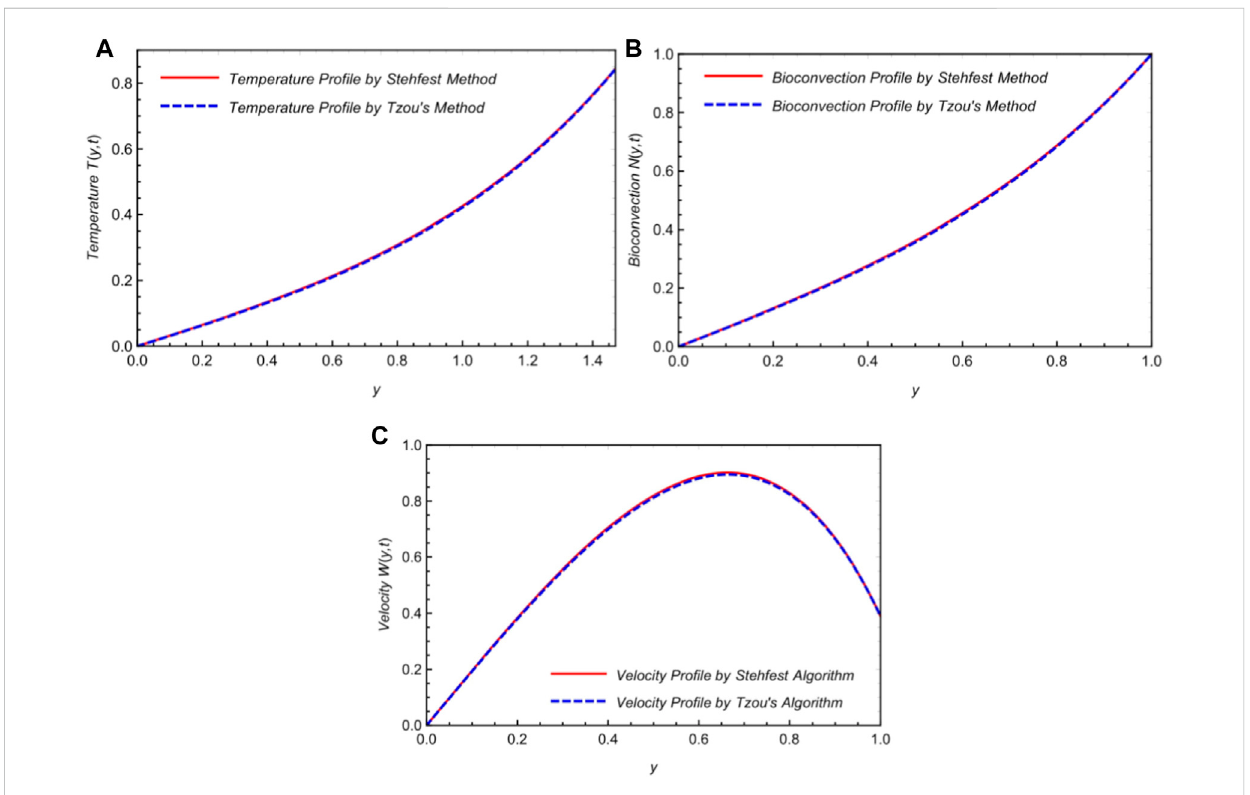
FIGURE 13 Comparison of governed equations for different numerical